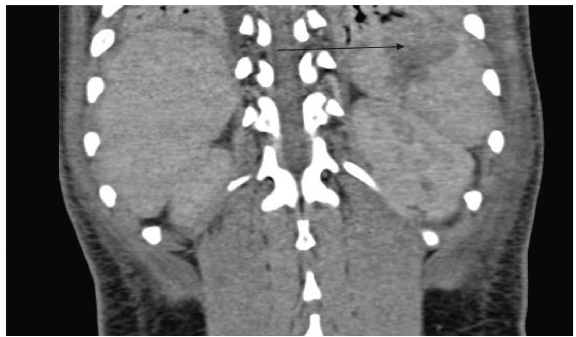
Figure 2: Computed tomography (CT) of the abdomen showing hypodense pyramidal wedge-shaped defect consistent with splenic infarcts (black